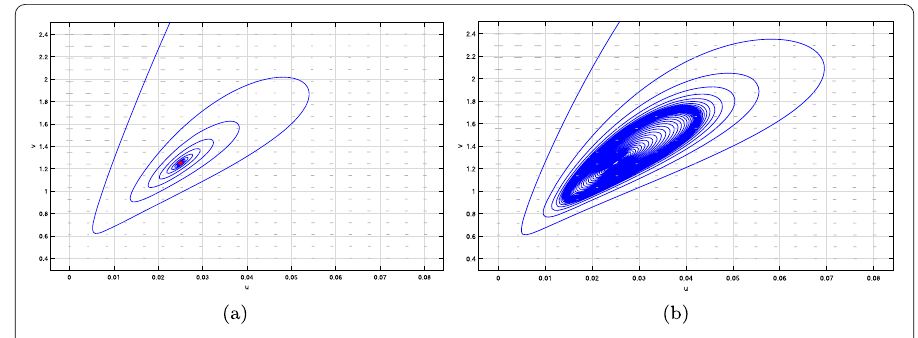
Figure 1 Phase portrait of system (2.1) with parameters in (4.1): ( a ) the equilibrium is asymptotically stable where d = 1.3 > d 0 ; ( b ) the equilibriumis unstable and the periodic solution is stable where d = 1.18 < d